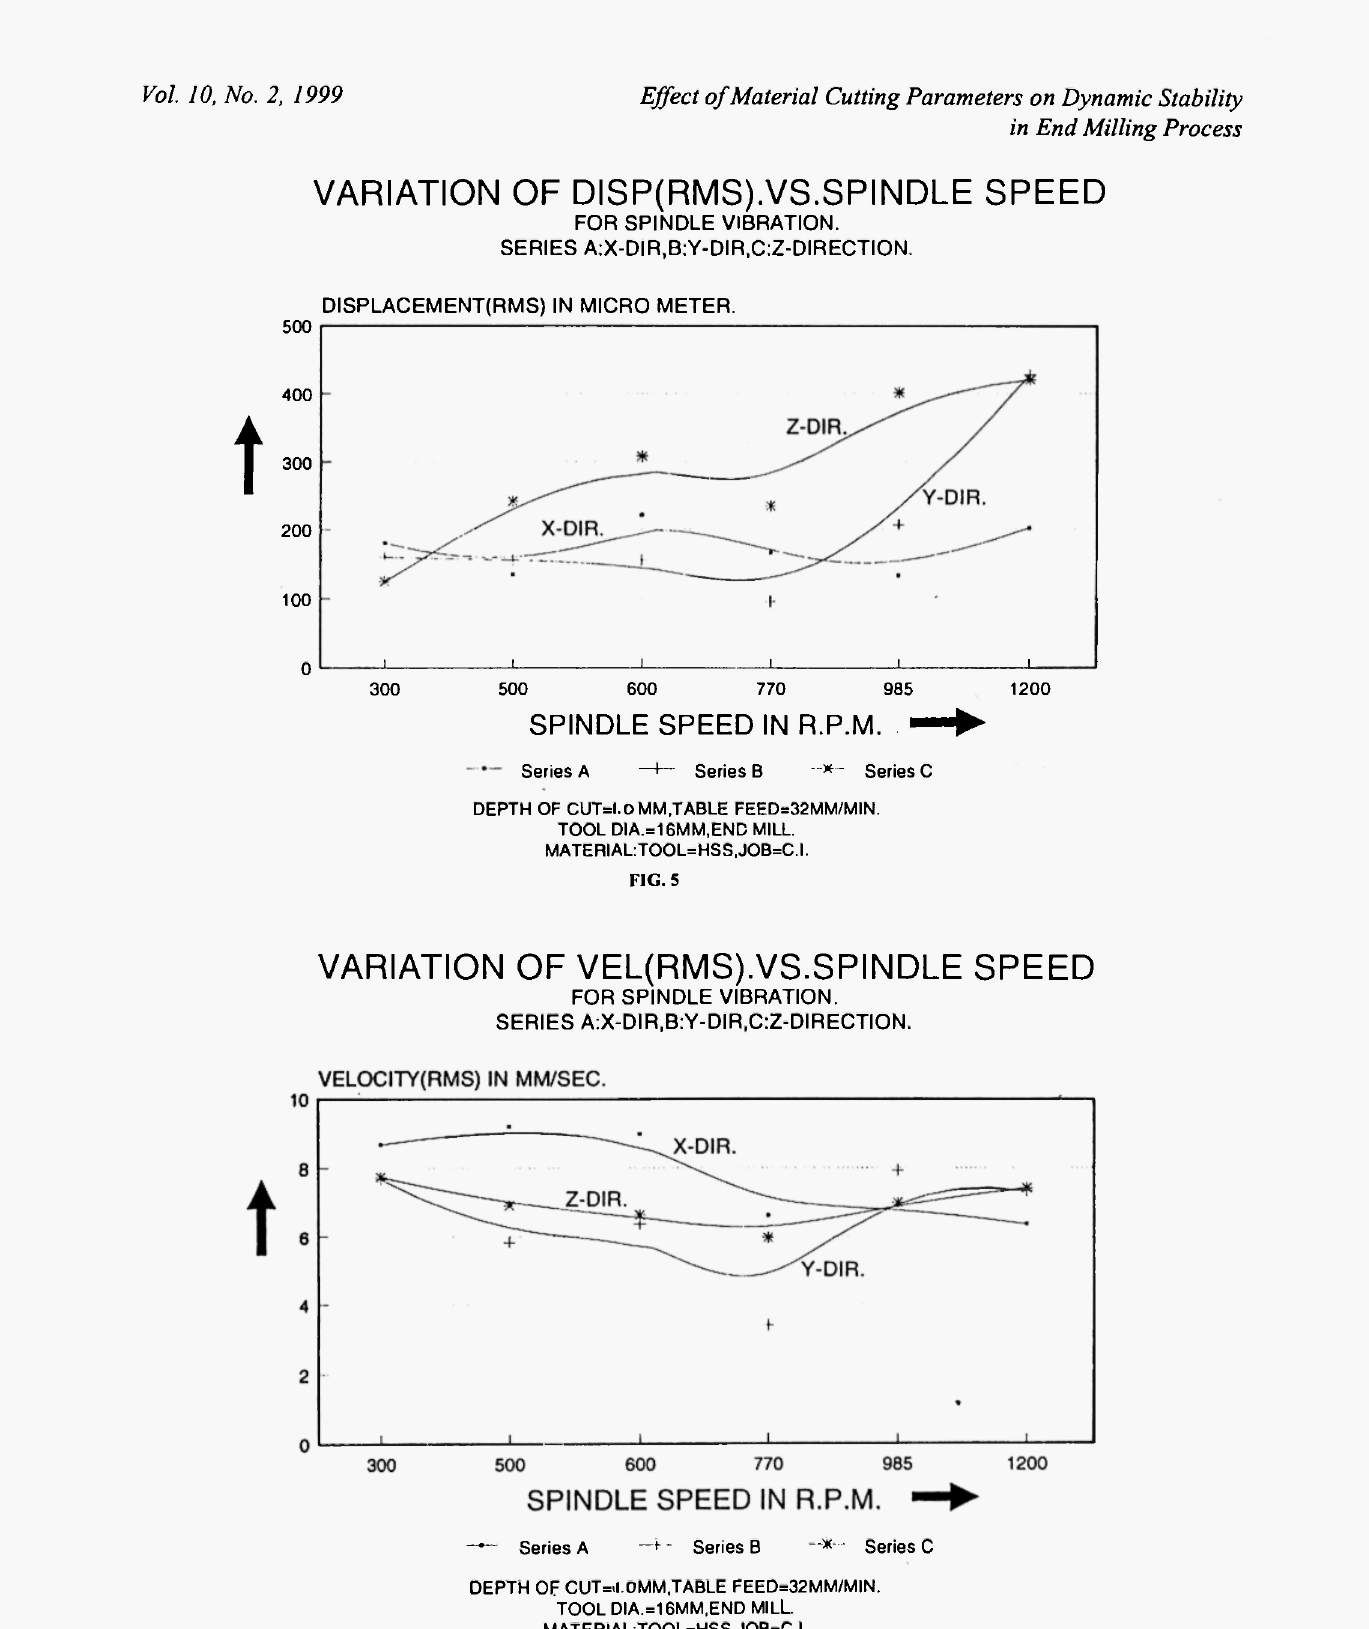
—— Series A - Series Β Series C DEPTH OF CUT=.I OMM,TABLE FEED=32MM/MIN. TOOL DIA.=16MM,END MILL.